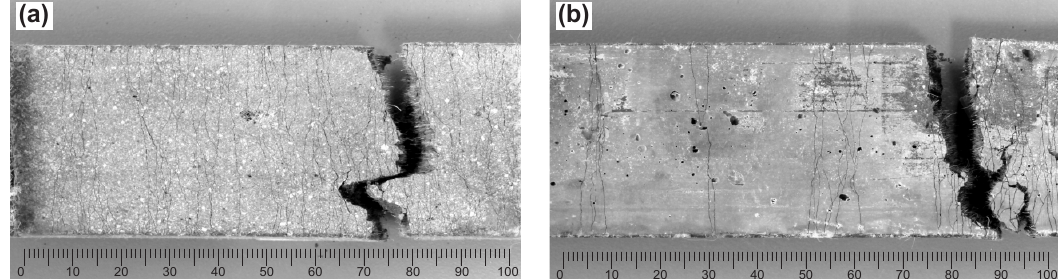
Figure 12. Representative crack patterns of specimens after failure in uniaxial tension tests: ( a ) C-print specimen, and ( b ) C-cast specimen.